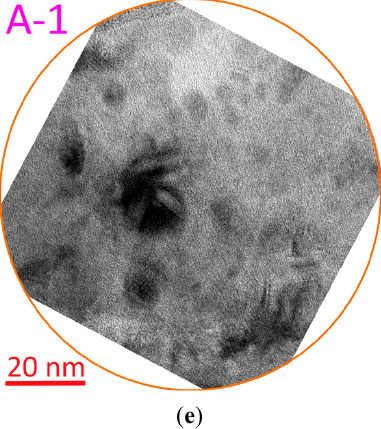
Figure 9. ( a ) General view of the lamella and localization of the areas for further studies; ( b ) Area B and HTEM image of the transition layer; ( c ) Area A, localization of line L2 and regions for SAED, results of the analysis of SAED 1 and SAED 2; ( d ) results of the study of change in the elemental composition along lines L1 and L2; ( e ) HTEM image of Area A-1. The localization of areas A, B and the line of study of the elemental composition L1 is shown in Figure 7a. The localization of area A-1 and the line of study of the elemental composition L2 are shown in Figure 7c.